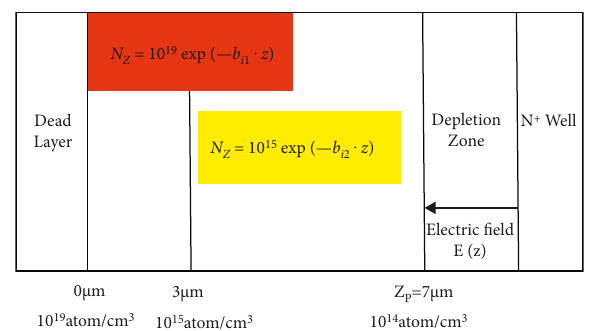
Figure 7: Electron multiplication layer multisegment exponential doping structure